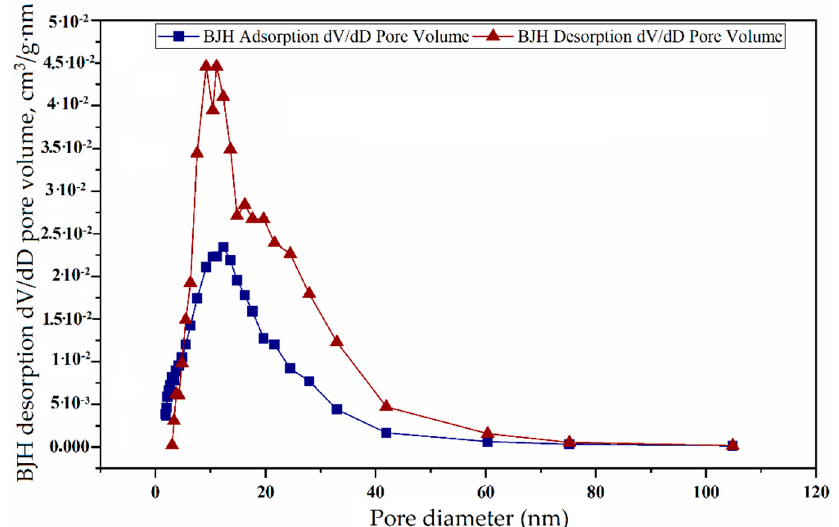
Figure 13. BJH adsorption and desorption of pore volume of Co/Al 2 O 4 catalyst.